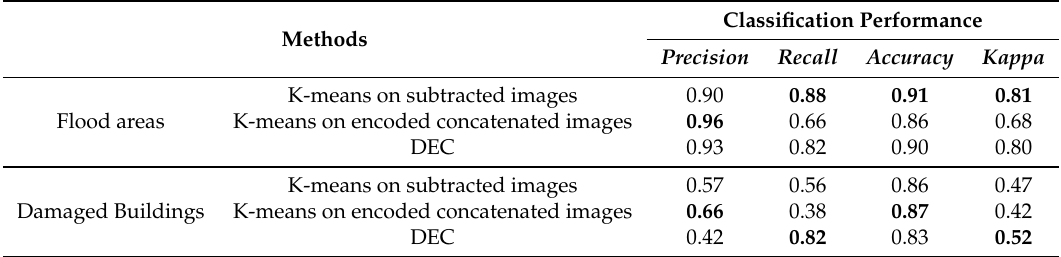
Table 4. Performance of clustering algorithms on ASTER images. The best results in each column are in bold.